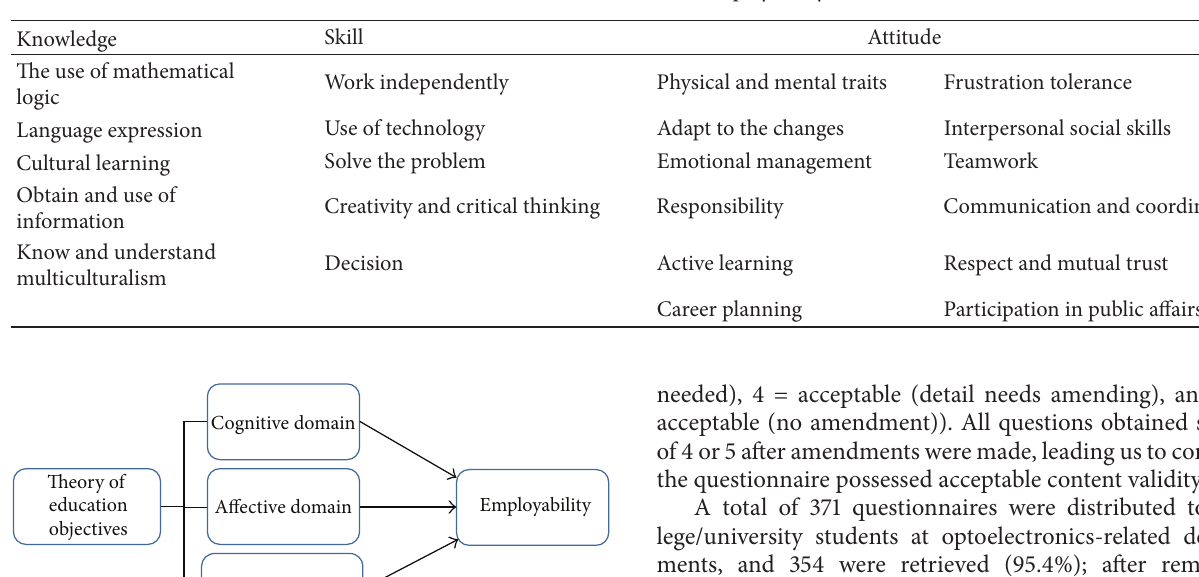
Table 1: Three dimensions of employability.